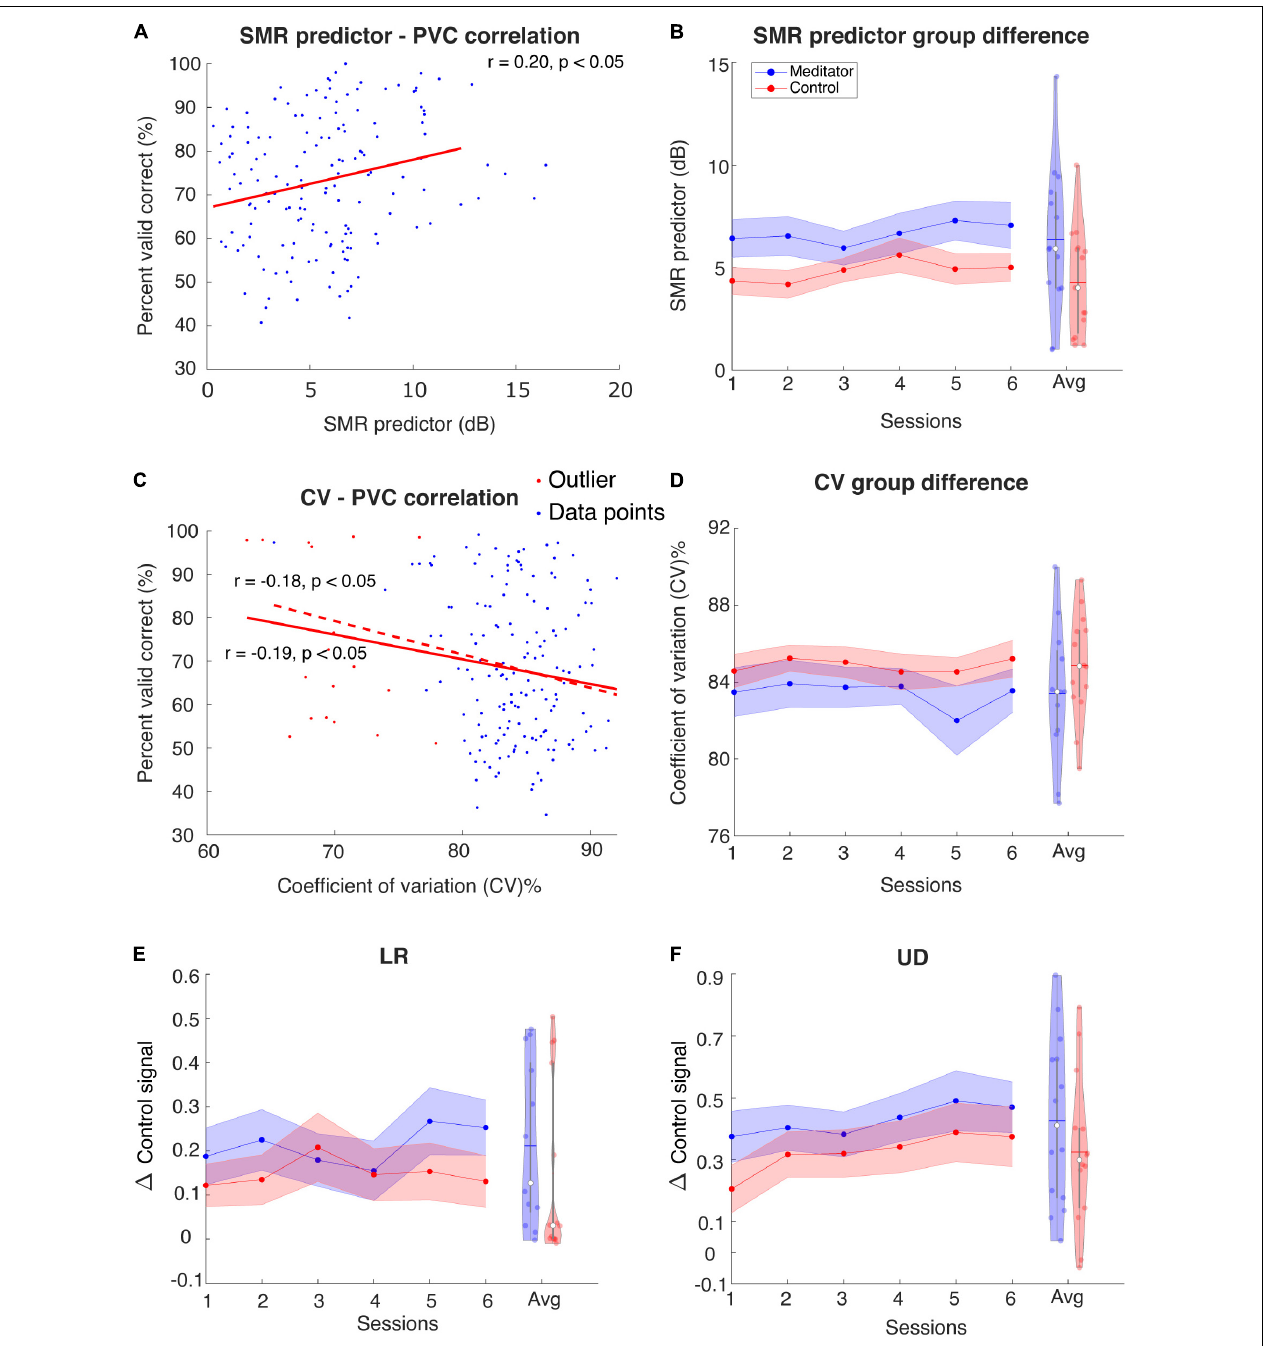
FIGURE 5 | (A) Regression between SMR predictor and PVC for UD task. Red line is regression line. For LR the correlation is not significant (plot not shown). (B) Group averaged SMR predictor for the meditator group and control group. Violin plot shows the session-averaged result. (C) Regression between resting-state stability and PVC for LR task. For UD task the correlation is only significant before excluding outliers (plot not shown) (D) Group averaged stability for the meditator group and control group. Violin plot shows the session-averaged result. (E,F) Group averaged (cid:49) control signal for (E) LR and (F) UD. Violin plot shows the session-averaged